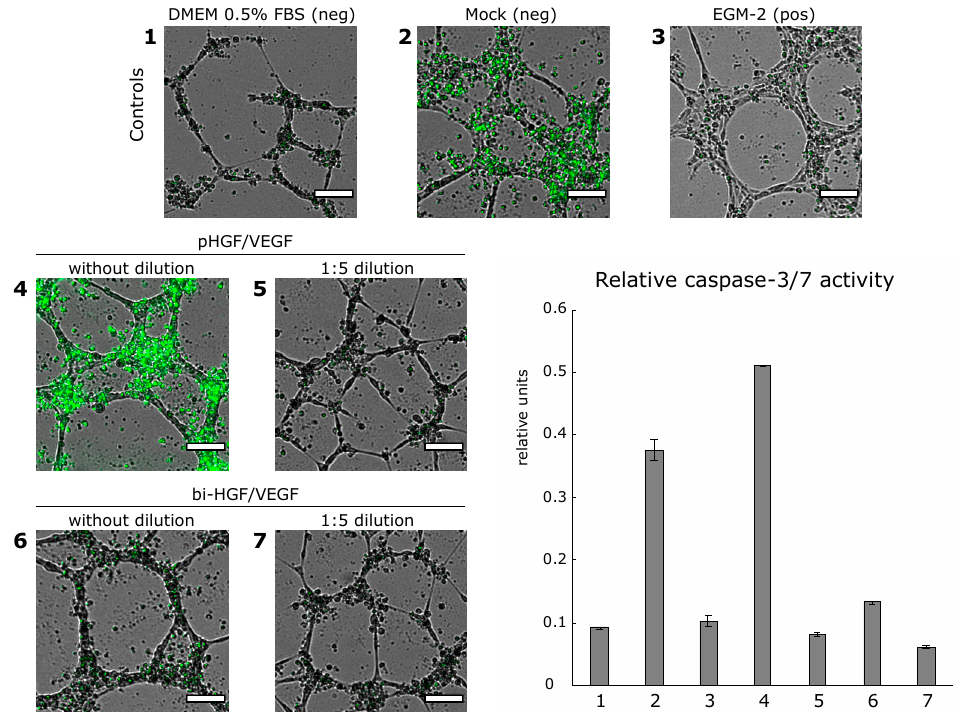
Pharmaceutics 2020 , 12 , x FOR PEER REVIEW